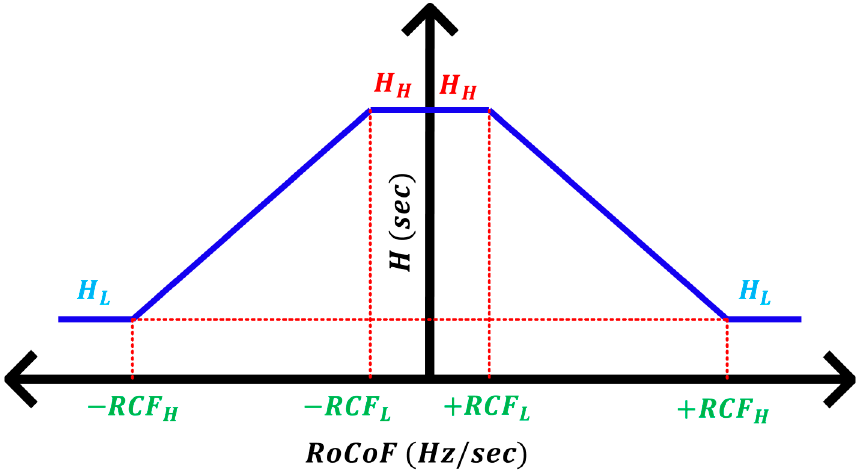
Figure 11. Proposed Droop-Inspired method characteristics to estimate the value of the inertia dynamically as a function of RoCoF.